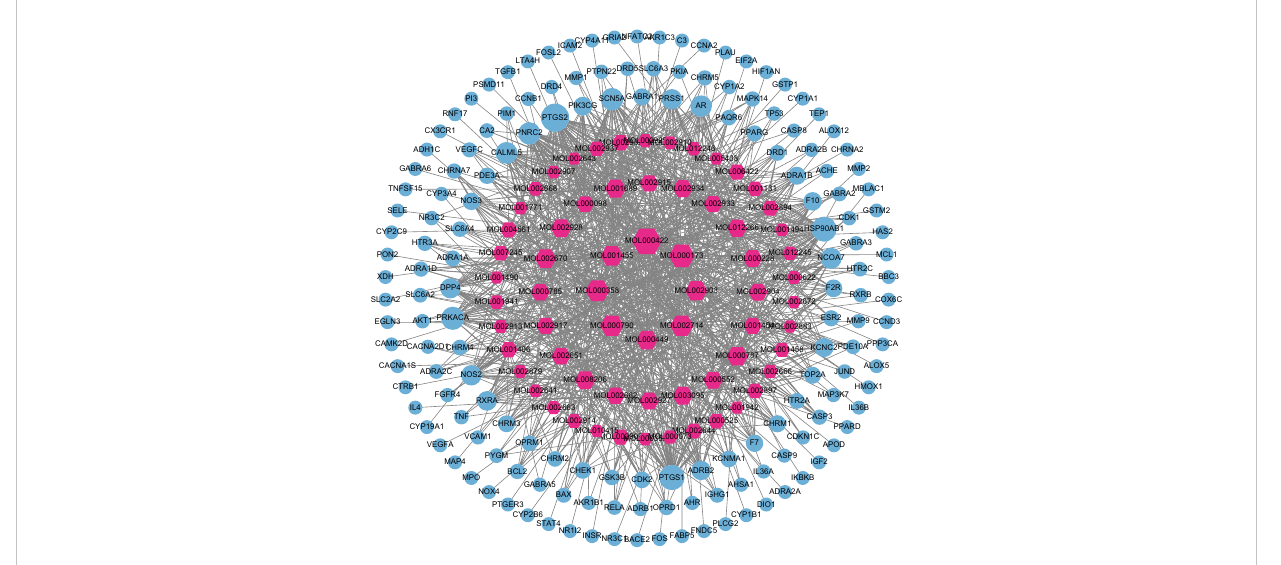
FIGURE 6 Composition-target network of HLJDD. The red hexagon is the active ingredient of the drug; and the blue circle is the target.